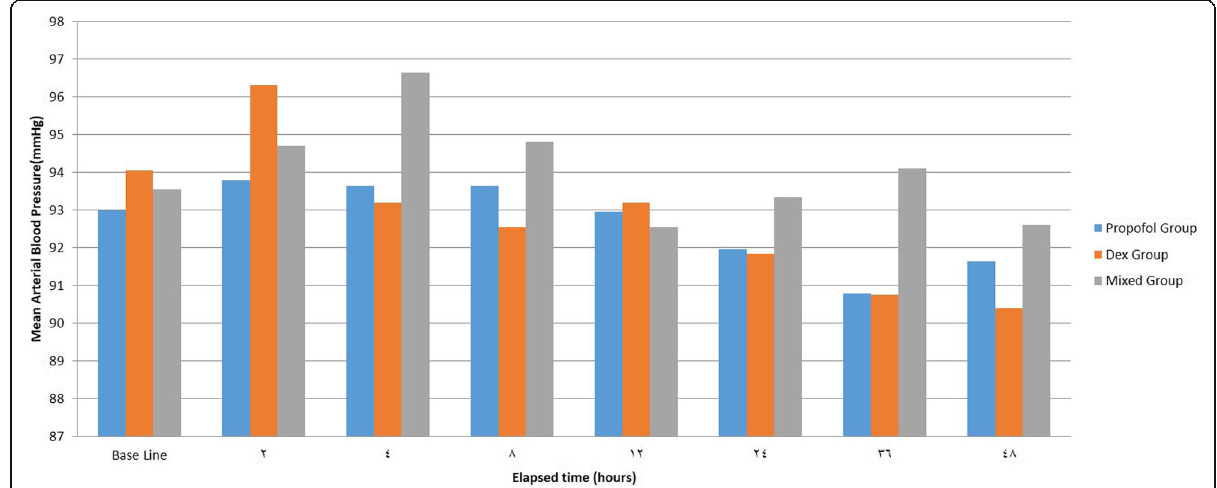
Fig. 4 Mean arterial blood pressure changes in the studied groups